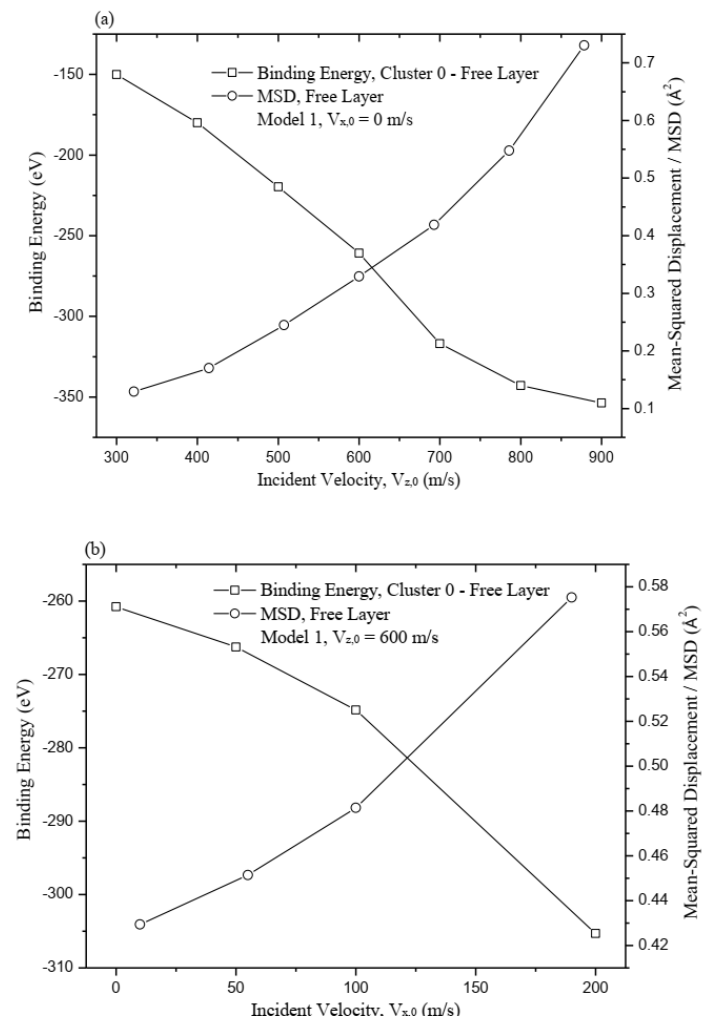
Figure 5. Binding energy between Cluster 0 and free layer and MSD of free layer in Model 1: ( a ) with different V z ,0 at V x ,0 = 0 m/s and ( b ) with different V x ,0 at V z ,0 = 600